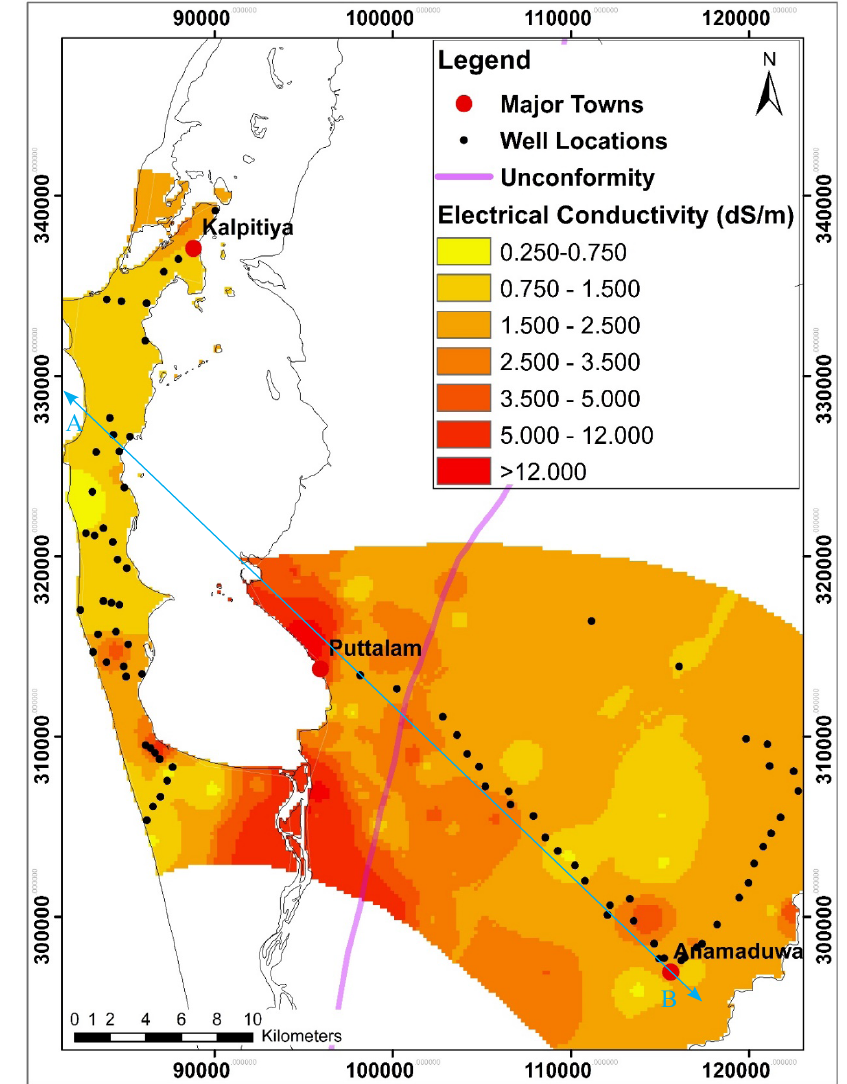
Figure 7: Spatial distribution of electrical conductivity in the study area. The cross-section of AB is schematically represented in Figure